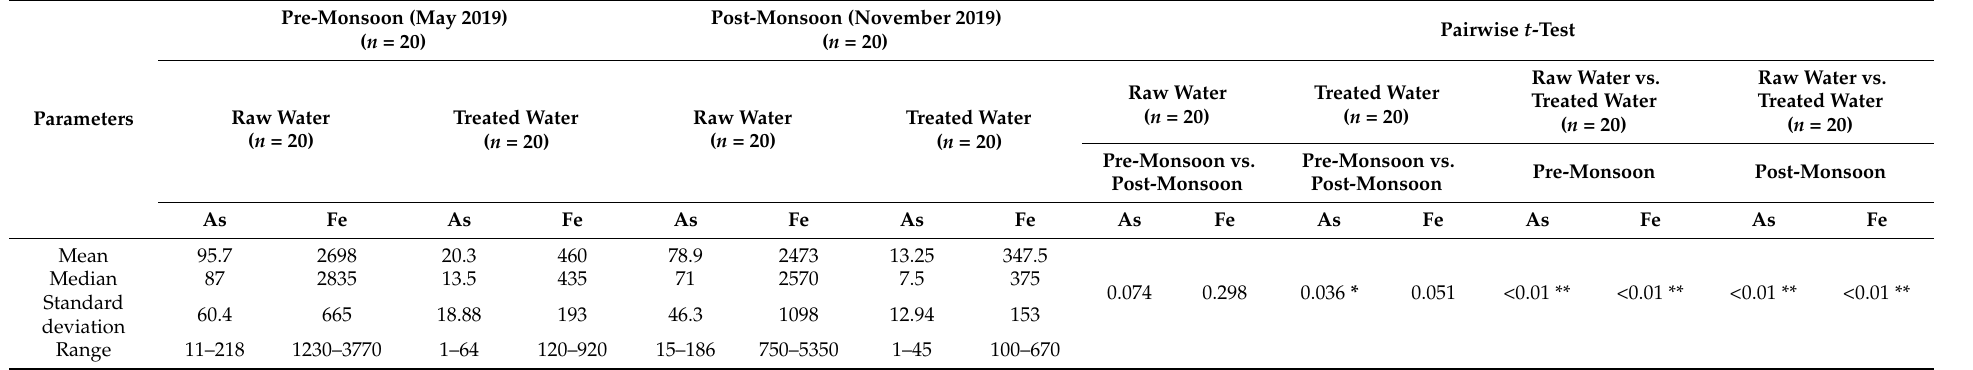
Table 1. The summary descriptive statistics of As and Fe ( µ g L − 1 ) in raw water and treated water by AIRP from rural areas in